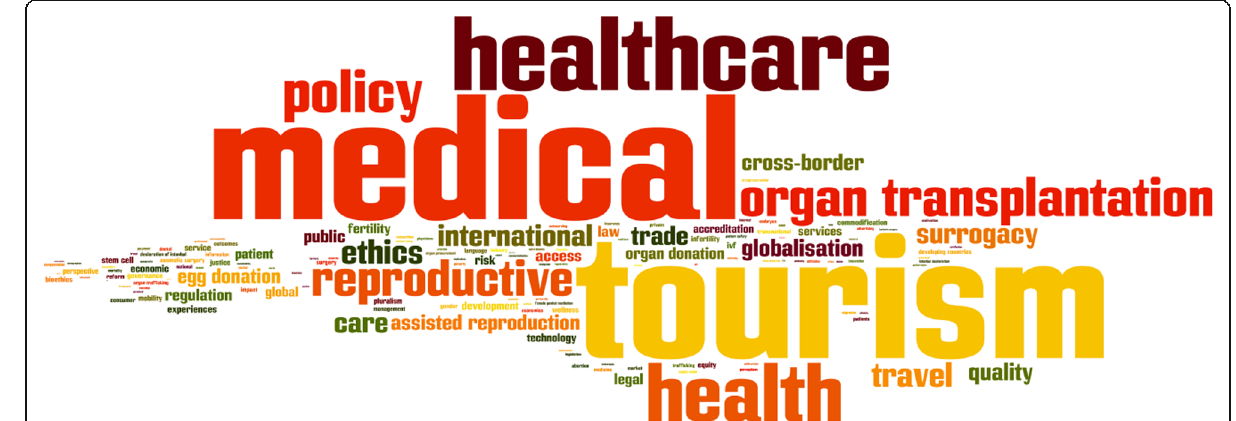
Fig. 6 Tag cloud of key themes in policy-related medical tourism